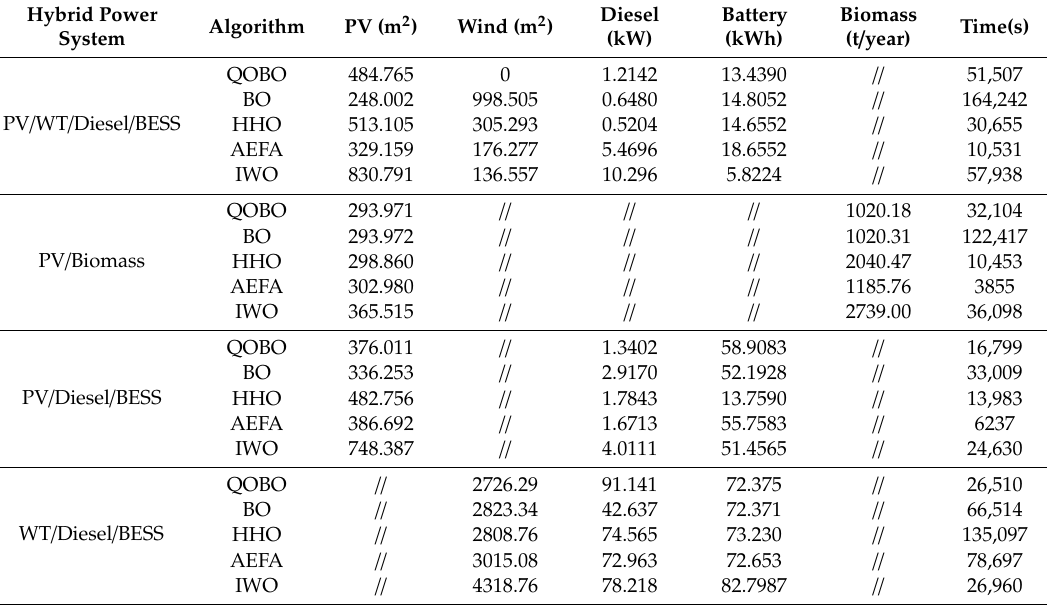
Table 2. Sizing results of di ff erent scenarios obtained from di ff erent optimization methods.